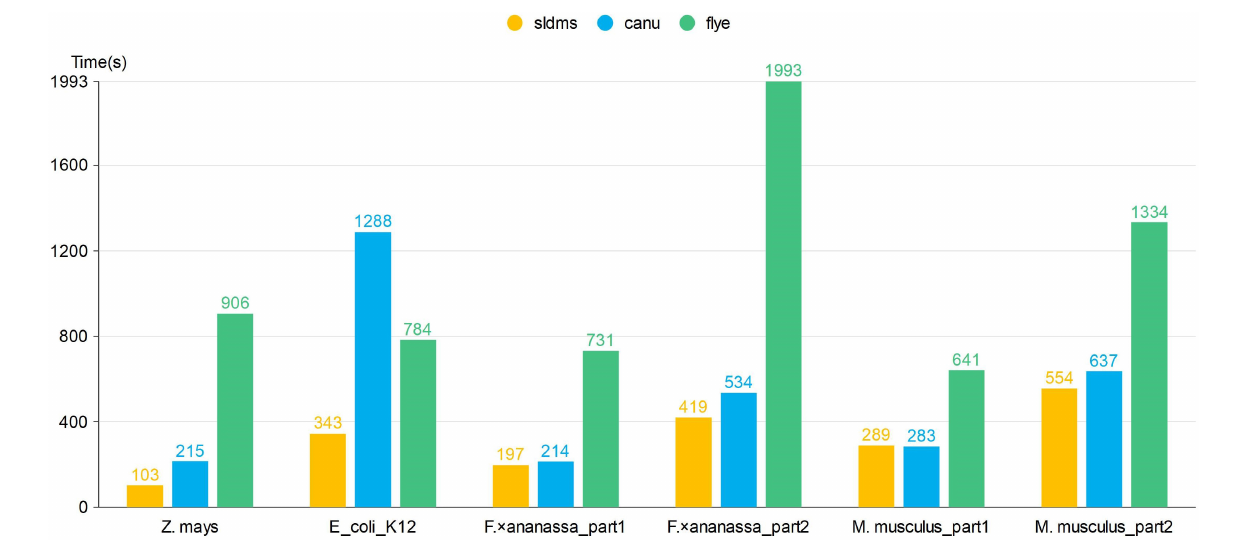
Frontiers in Plant Science |